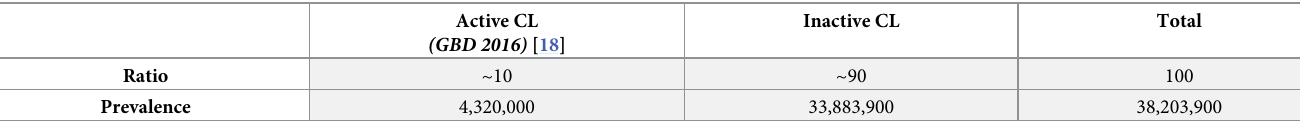
Table 5. Estimating the prevalence of inactive CL.